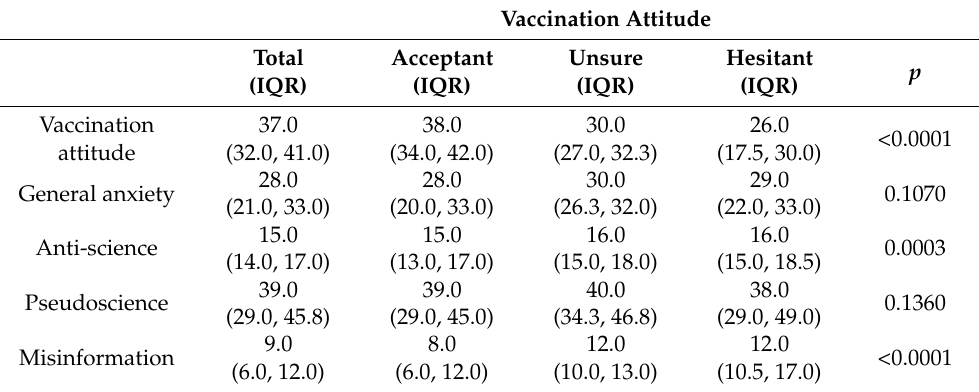
Table 4. Psychological variables and vaccination attitude in September